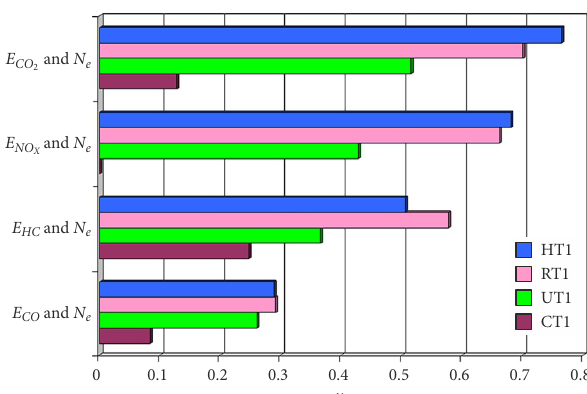
Figure 17. Coefficient of Kruskal’s gamma correlation g between the pollutant emission intensity ( E CO , E NO , E CH , E CO ) , E NO , E CH , E CO ) 2 2 X X and the non-negative effective power N e in individual tests (CT1, UT1, RT1, HT1)